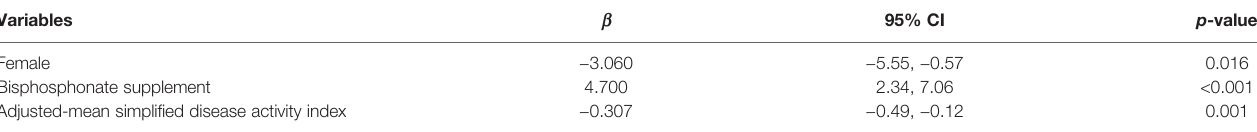
TABLE 5 | In fl uence of various factors on % D BMD at the lumbar spine during the fi rst year of follow-up by multiple linear regression analysis in 144 RA patients.